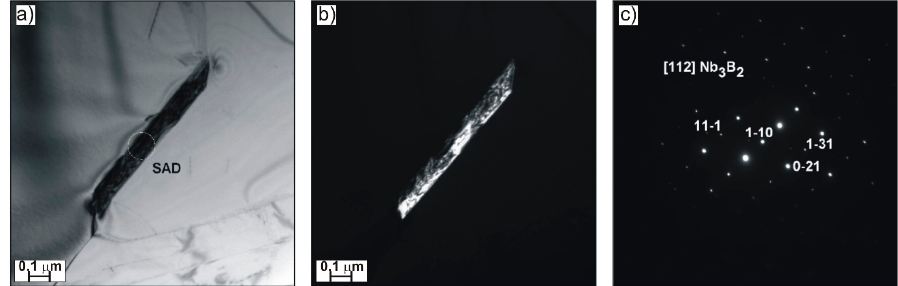
Figure 5. Nb 3 B 2 phase precipitates in the Ti-45Al-8Nb-0.5(B, C) alloy: bright field ( a ), dark field ( b ), and electron diffraction ( c ).